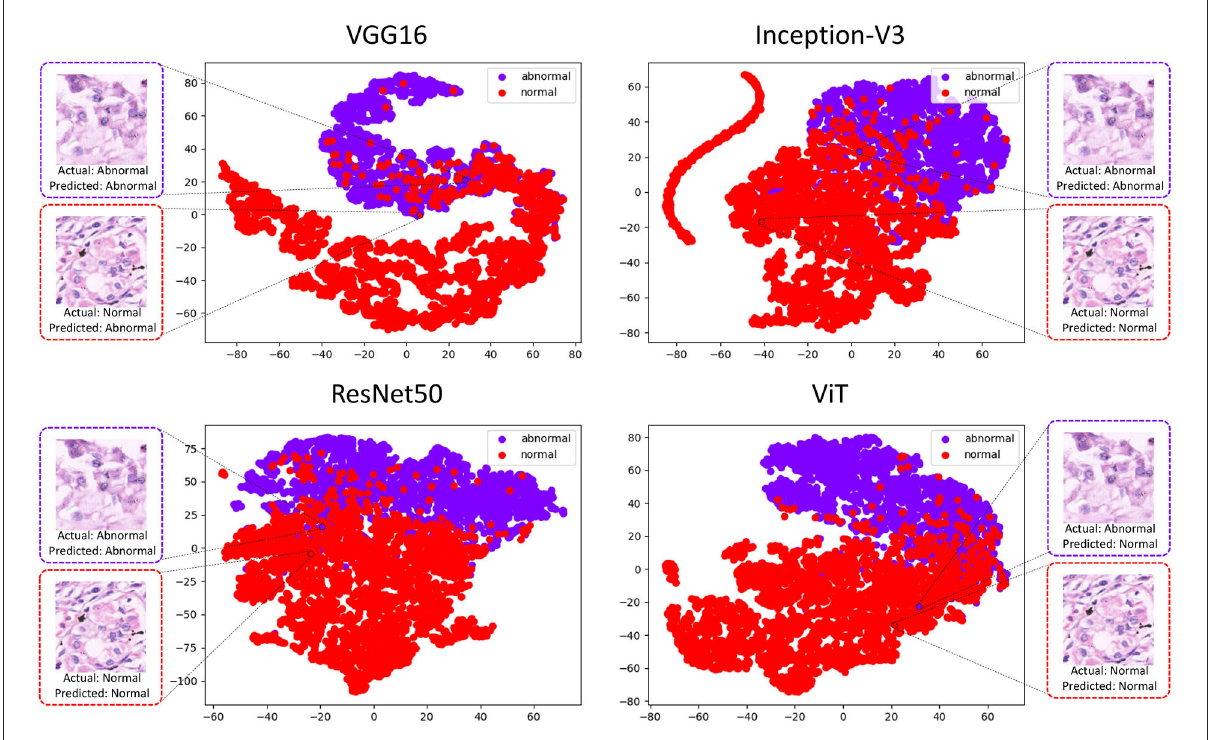
FIGURE3 Plot of results from t-SNE analysis of four deep learning classification